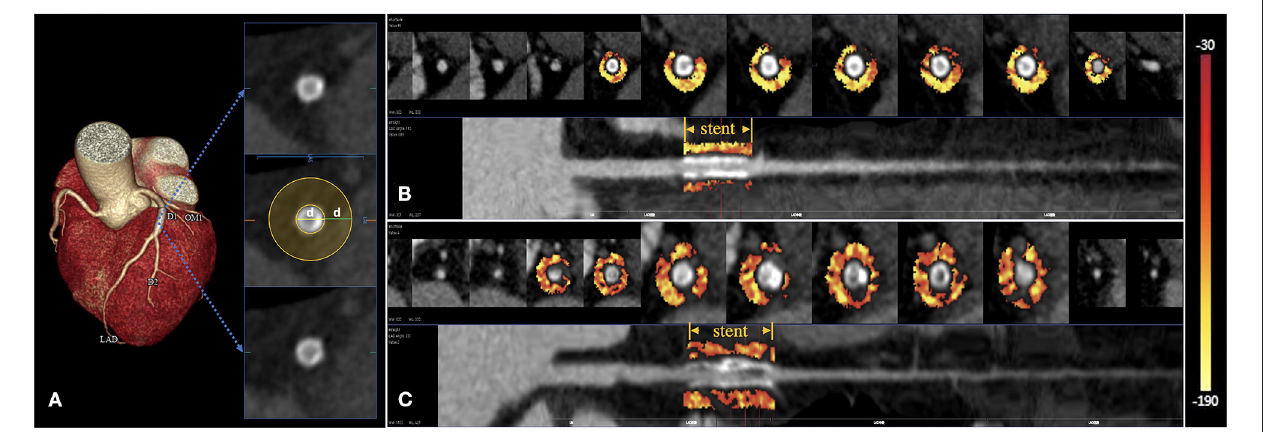
FIGURE 2 | Peri-stent PVAT analysis by DL-based methods. The extent of peri-stent PVAT is visualized in the cross-sectional and straightened views through the adipose tissue Hounsfield unit color table (range − 190 HU to − 30HU), representing the peri-stent FAI values. (A) The peri-stent PVAT was defined as epicardial adipose tissue within a radial distance equal to the diameter of the stent. (B) A patient with mid-LAD stent placement. CCTA suggested a non-ISR with a peri-stent FAI of − 96 HU. (C) Another patient with proximal-LAD stent implantation. ISR can be seen on the CCTA with a peri-stent FAI of − 75